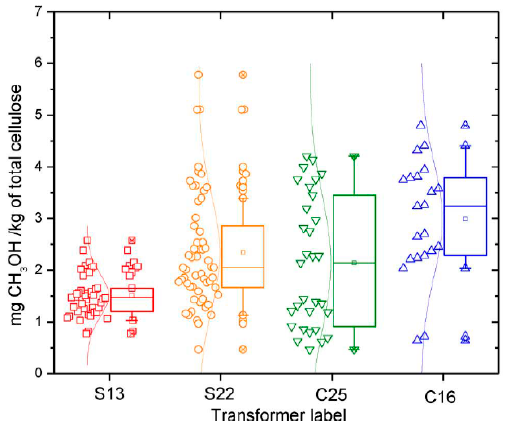
Figure 12. Comparison of methanol marker statistics on Électricité de France’s (EDF) power plant transformers [2].